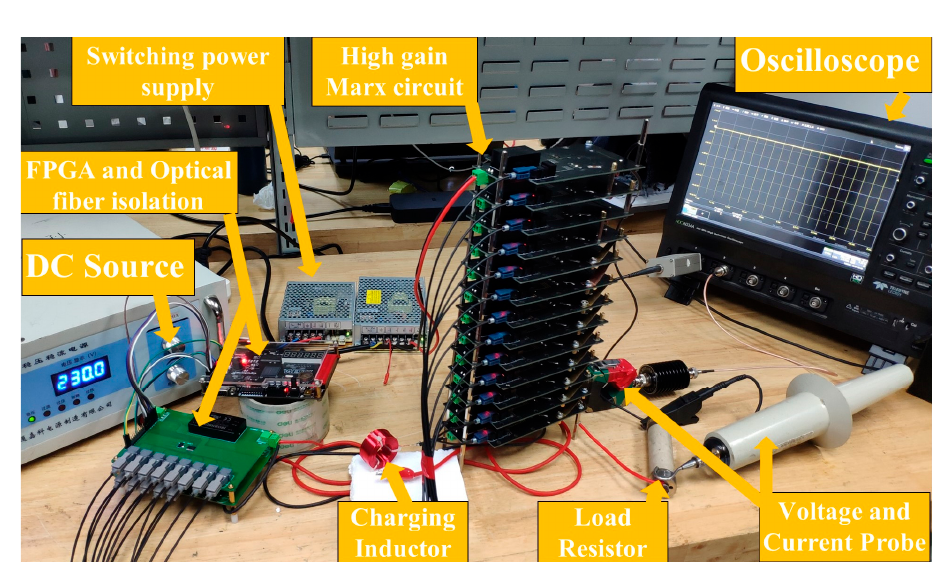
Figure 9. Experimental setup.